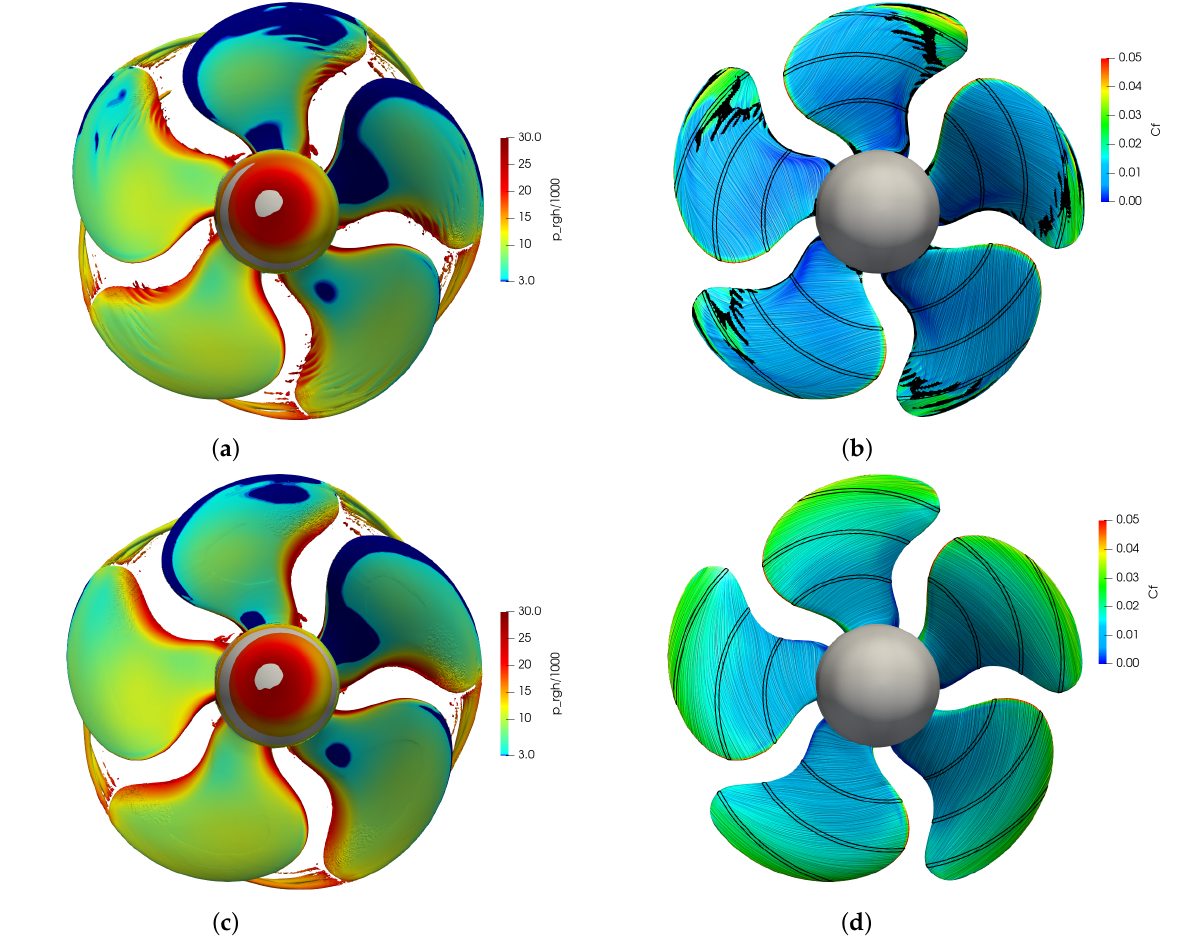
Figure 18. Non-cavitating condition predictions. ( a , c ): iso-surface of Q = 3 × 10 5 colored by pressure; ( b , d ): predicted SepInd with wall limiting streamlines colored by C f ; with γ − Re θ (upper row) and k − ω SST (lower row) turbulence